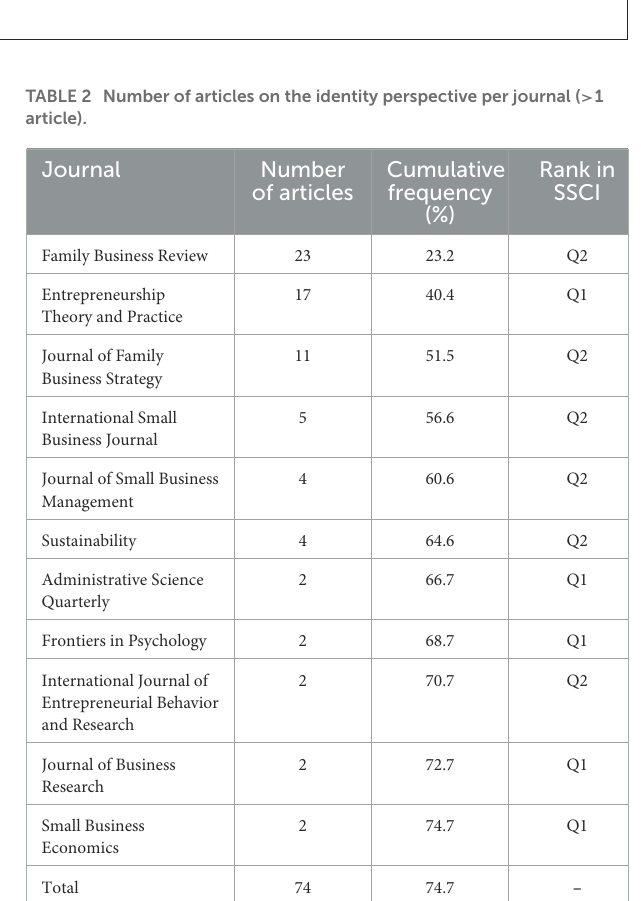
FIGURE3 Number of articles by year.